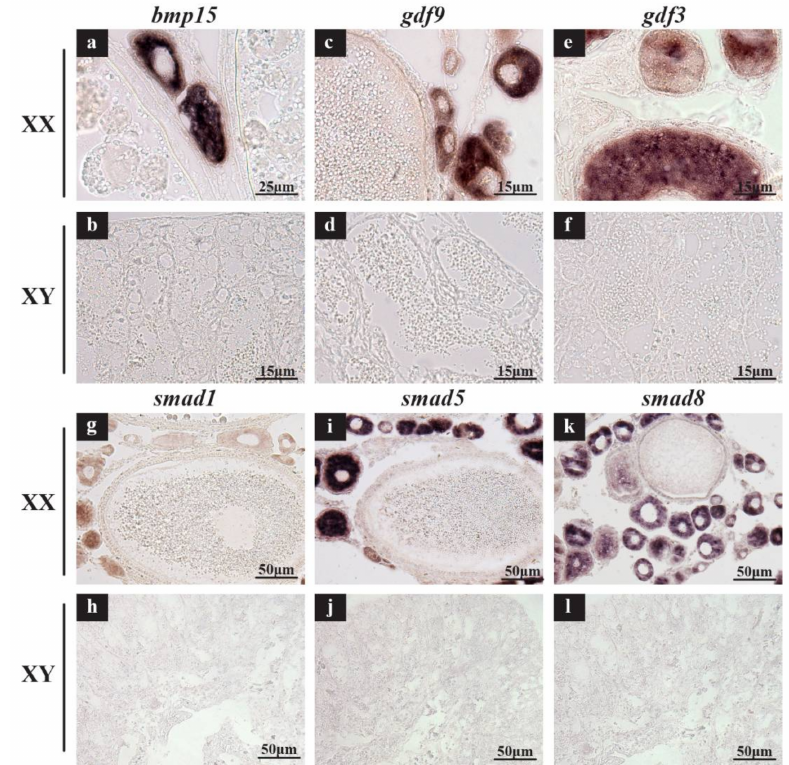
Figure 8. Cellular location of 6 TGF- β pathway genes in tilapia gonads at 180 dah by ISH. Specific signals (brown) of bmp15 , gdf9 , gdf3 , smad1 , smad5 and smad8 were observed in the cytoplasm of oocytes in the ovary ( a , c , e , g , i , k ). In contrast, no signal of these genes was observed in any cells of the testis ( b , d , f , h , j , l ). Scale bar: ( a ) 25 µ m; ( b – f ) 15 µ m; ( g – l ) 50 µ